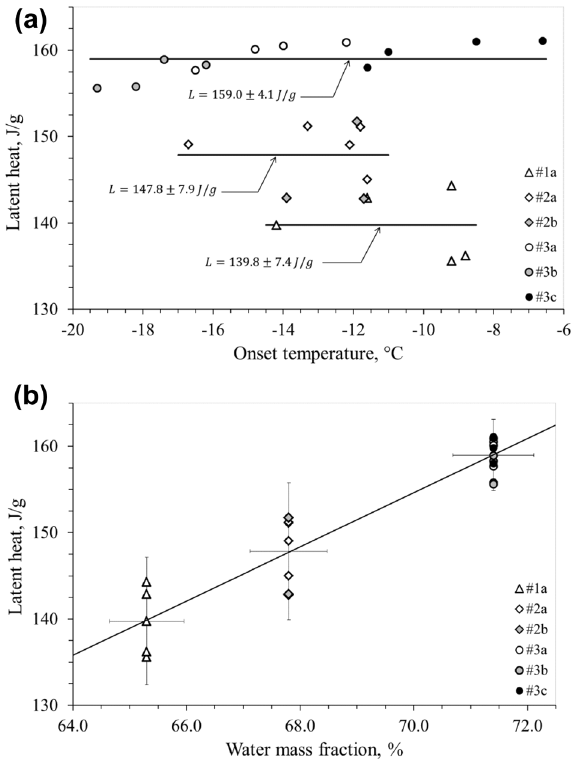
Figure 4. ( a ) Measured latent heat vs onset temperature of all liver samples. Solid lines represent the average latent heat values for the three liver samples. In the callouts, both the average latent heat L and the uncertainty at